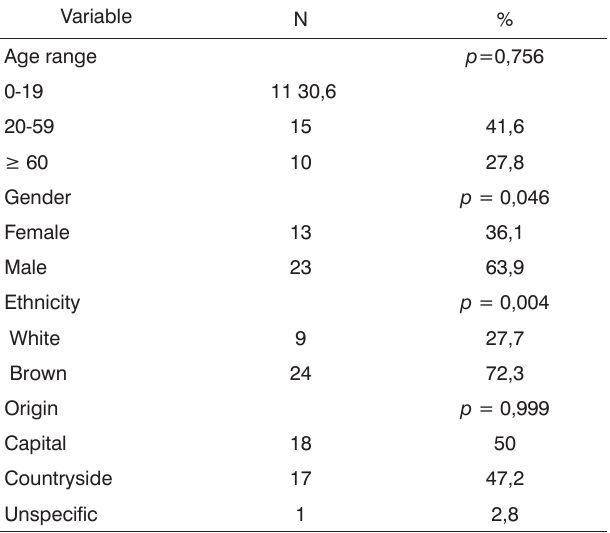
Table 1. Sample characteristics